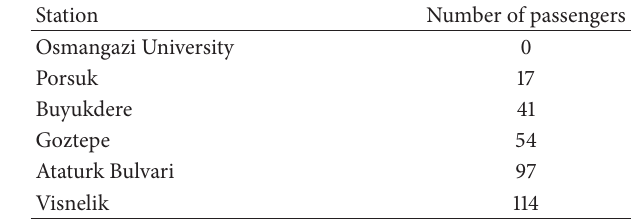
Table 5: Number of passengers at each station.